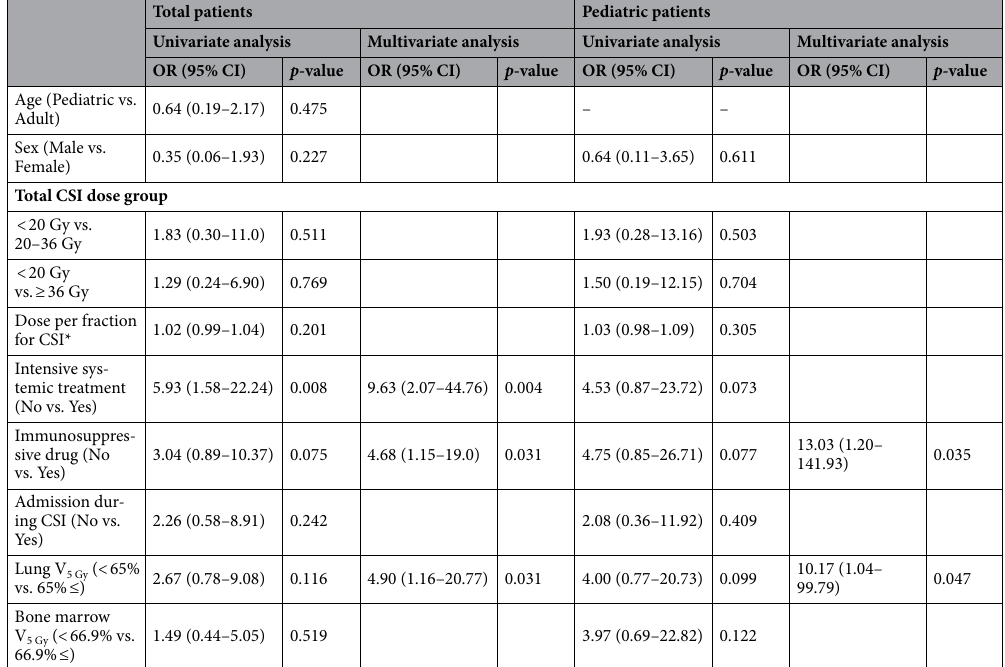
Table 4. Prognostic factors for pneumonia in all patients, pediatric patients inclusive. The foreparts of the parentheses were set as the reference groups in the multivariable analysis. OR, odds ratio; CI, confidence interval; CSI, craniospinal irradiation; Gy, gray; V 5 Gy , volume of organs at risk of receiving more radiation than 5 Gy. *Dose per fraction for CSI was treated as a continuous variable.